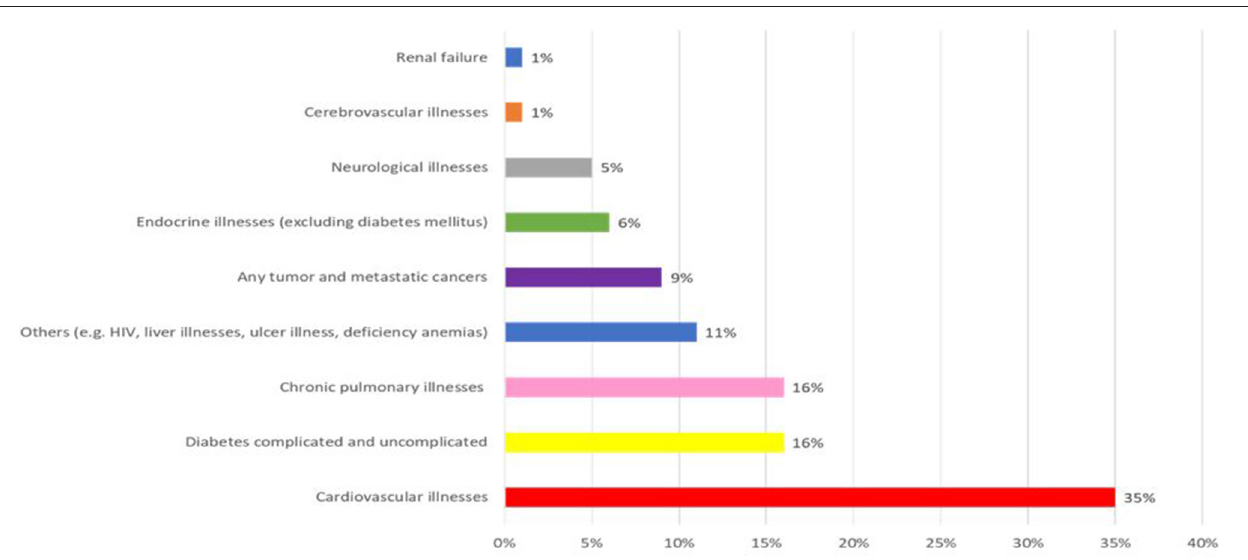
FIGURE 1 | Prevalence of chronic physical illnesses (CPI) major health categories. Cardiovascular illnesses included: hypertension, myocardial infraction, congestive heart failure, cardiac arrhythmias, valvular illnesses, peripheral vascular illnesses; diabetes included: diabetes mellitus type 2 and diabetes mellitus type 1 with systemic manifestations and without mention of complications; chronic pulmonary illnesses included: chronic obstructive pulmonary illnesses, pnemoconiosis, and lung illnesses due to external agents; other CPI included: blood loss anemia, ulcer, liver illnesses, AIDS/HIV, rheumatoid arthritis/collagen vascular illnesses, coagulopathy, weight loss, paralysis, deficiency anemia; any tumor and metastatic cancers including malignant neoplasm with/without metastasis; endocrine illnesses included: hypothyroidism, fluid, and electrolyte illnesses, obesity; neurological illnesses included: paralysis agitans, secondary Parkinsonism, Huntington’s chorea, other chorea, spinocerebellar illnesses, anterior horn cell illnesses, multiple sclerosis, other demmyelinating diseases of the central nervous system, convulsions, aphasia; cerebrovascular illnesses included: ocular ischemic syndrome, subarachnoid hemorrhage, intracerebral hemorrhage, other or unspecified intracranial hemorrage, transient cerebral ischemia, acute but ill-defined cerebrovascular illnesses, late effects of cerebrovascular illnesses; renal failure included: hypertensive renal disease, chronic renal failure, unspecified renal failure.